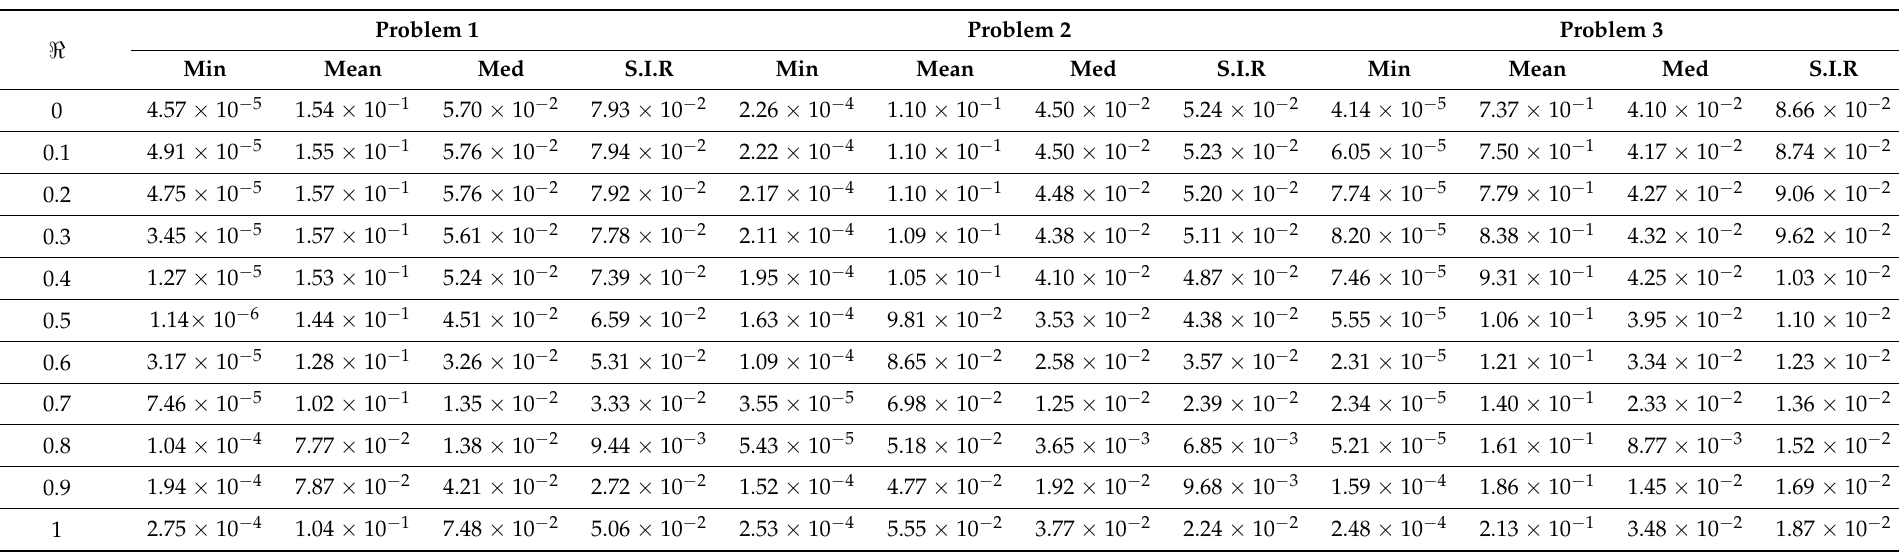
Table 2. Statistical interpretations for each problem of the